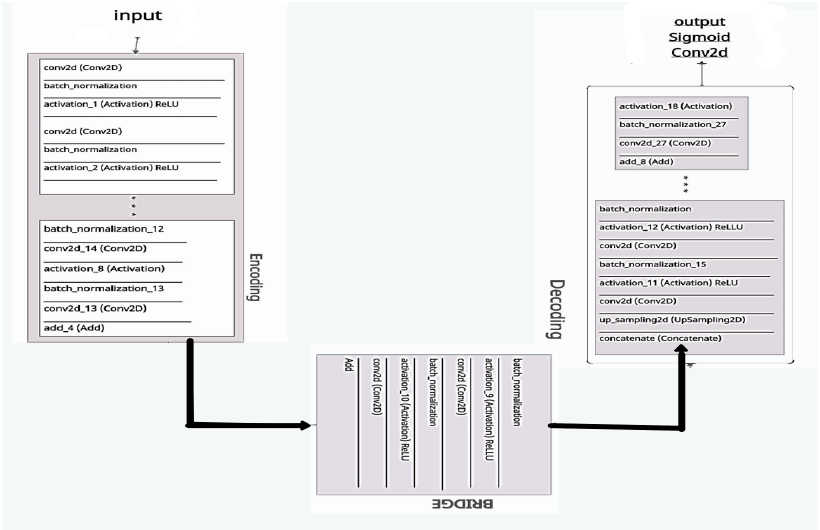
Figure 14. The proposed ResUNet architecture.